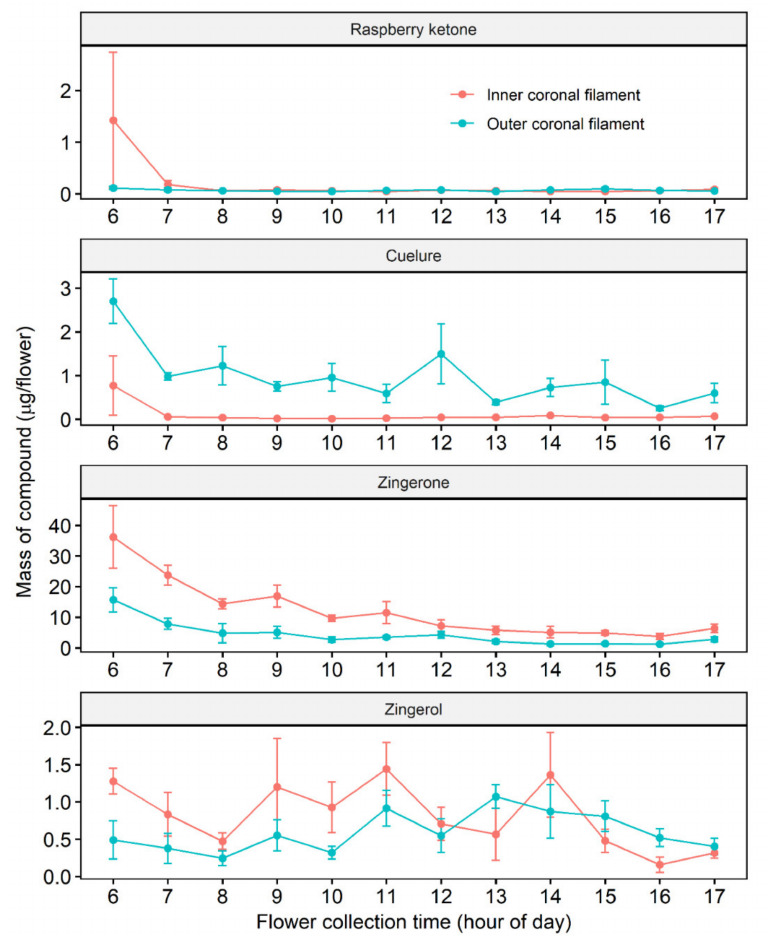
Figure 1. Diurnal changes of raspberry ketone, cuelure, zingerone, and zingerol in the coronal filaments of P. maliformis . Error bars represent standard errors that reflect variation across individual